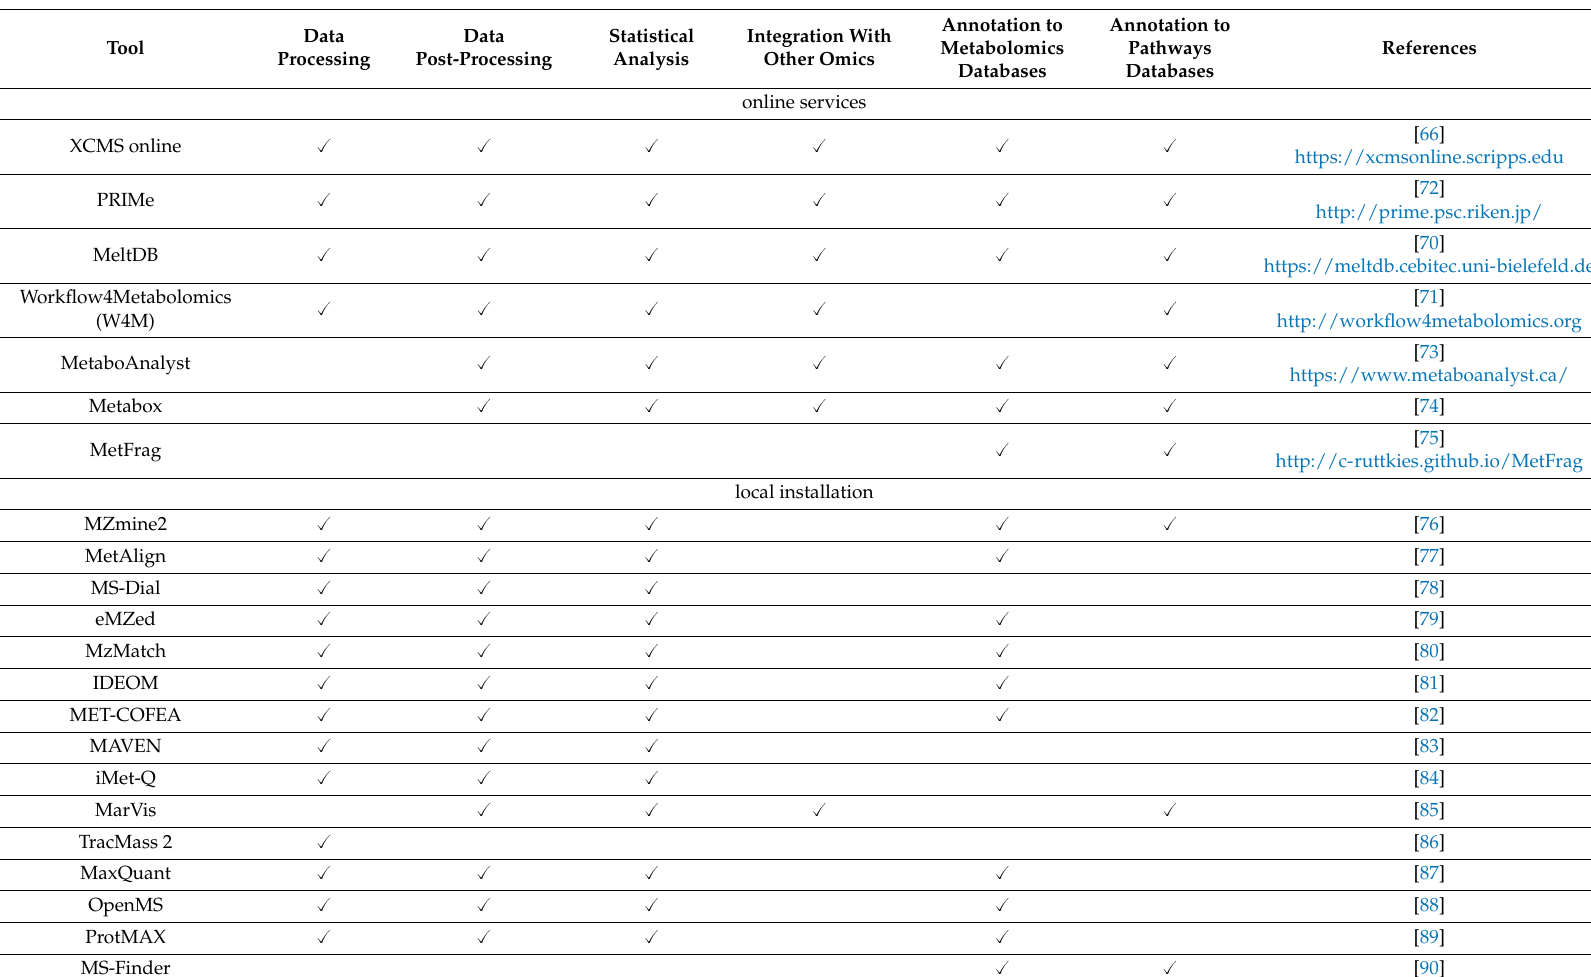
Table 2. Summary of functions on freely available metabolomics tools with graphical user interface for comprehensive workflow starting from data processing, post-processing, statistics, integration with other omics and metabolite